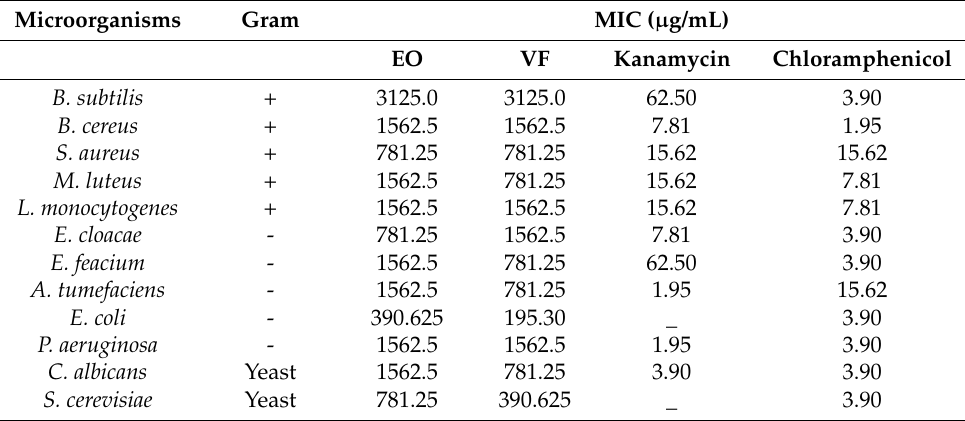
Table 2. Minimum inhibition concentrations (MIC) values of VF and